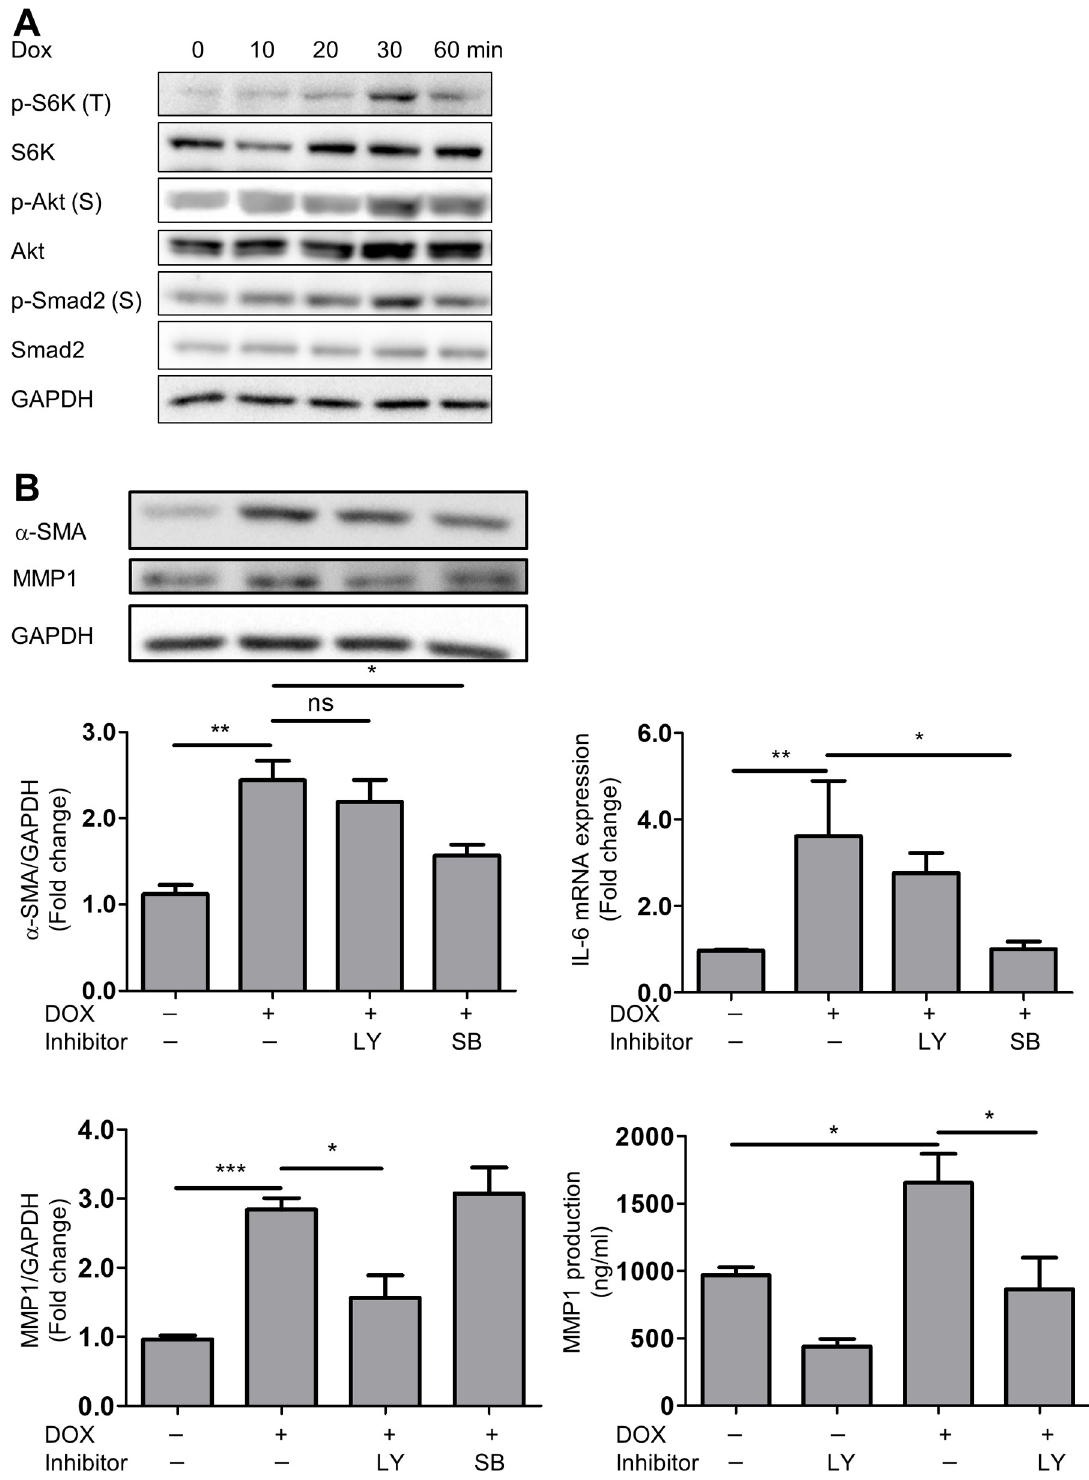
Fig 5. DOX phosphorylated Smad and Akt in HCFs. A, The time course of protein phosphorylation (p-S6K-t389, p-Akt-s473 and p- Smad2-s465/467) in HCFs stimulated by DOX (0.1 μ M) for 0 to 60 min. The original immunoblot image is shown in S8 Fig. B, A TGF- β /Smad inhibitor (SB431512) decreased the DOX-induced IL-6 and α -SMA expression. A PI3K inhibitor (LY294002) decreased DOX- induced protein expression and production of MMP1 in HCFs (n = 4–6; � p < 0.05, �� p < 0.01, ��� p < 0.001). The original immunoblot image is shown in S9